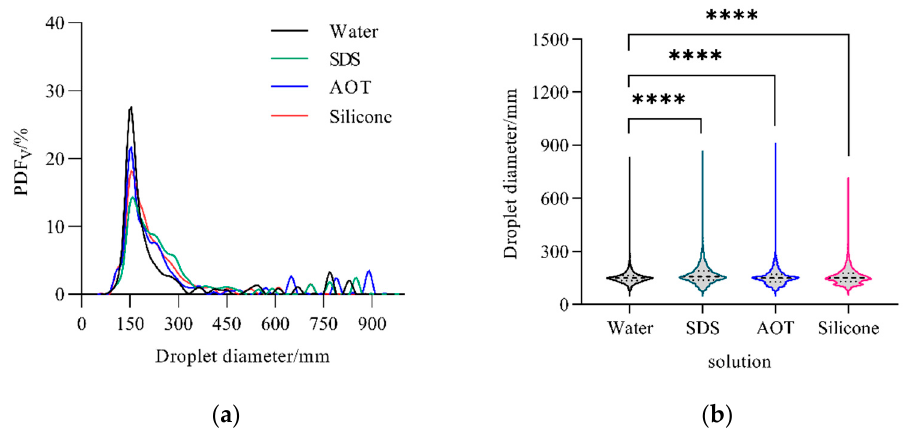
Figure 8. ( a ) Curve of probability volume density function (PDF V ). ( b ) Violin plots of drop size for the XR nozzle with different solutions. “****” indicates significance at p ≤ 0.0001.